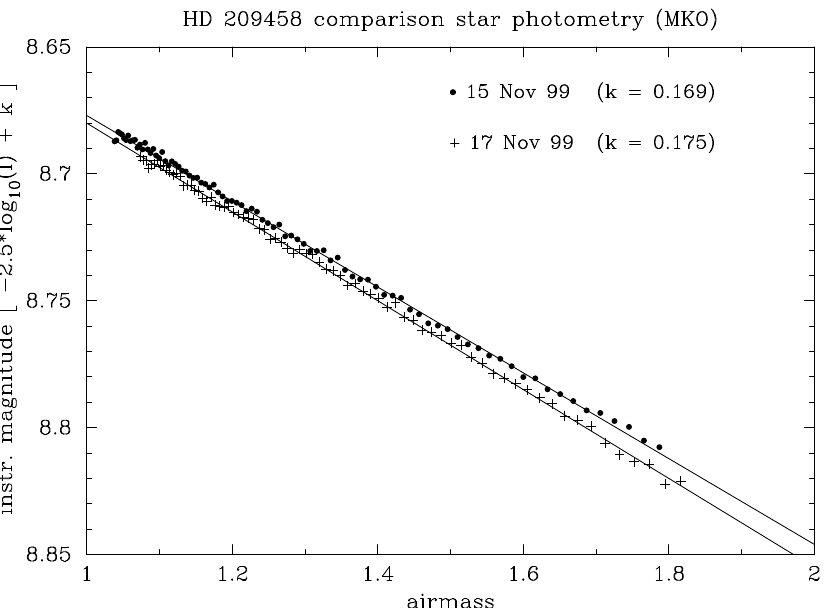
Fig. 4. Relative HD 209458 flux values for both on transit and off transit measurements for 15 and 17 November 1999,